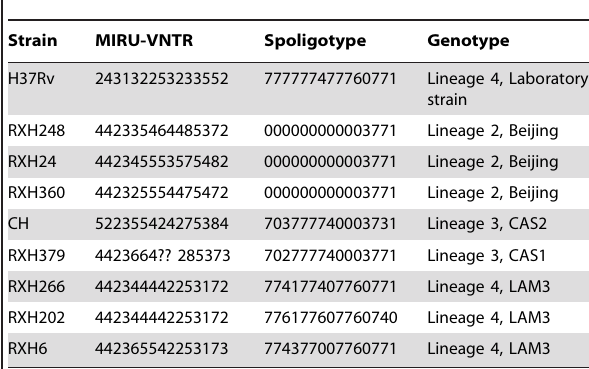
Table 1. Genotype of selected M. tuberculosis